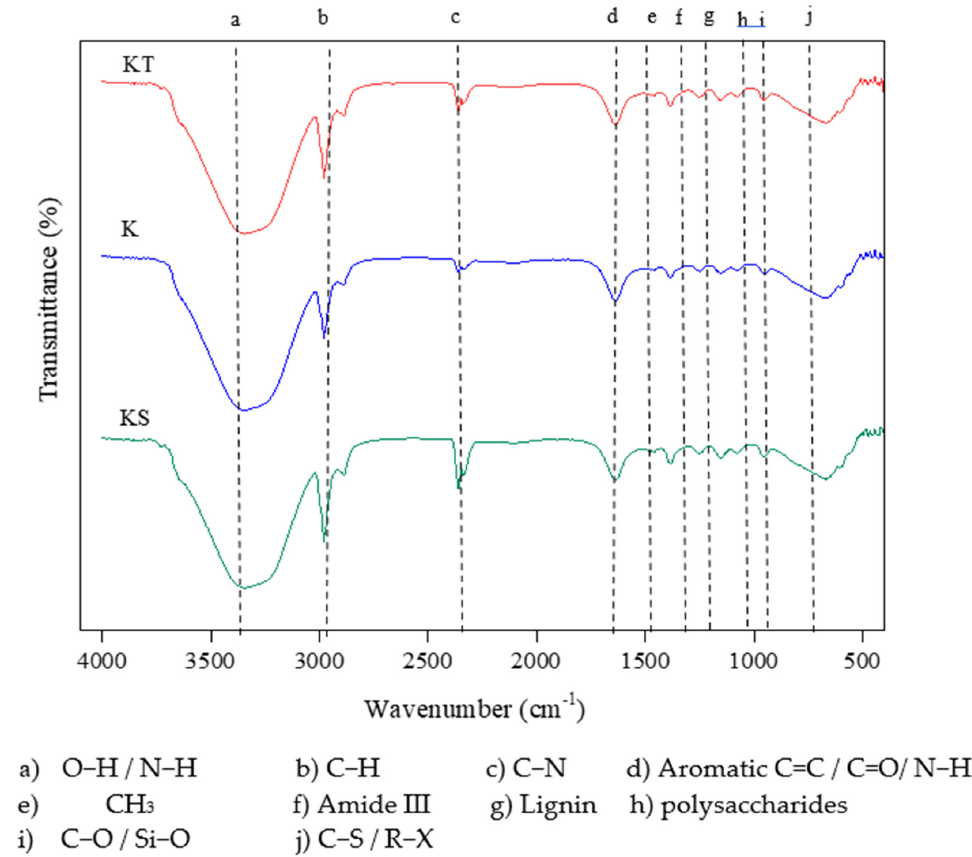
Figure 7. ATR-FTIR spectra of DOM samples.